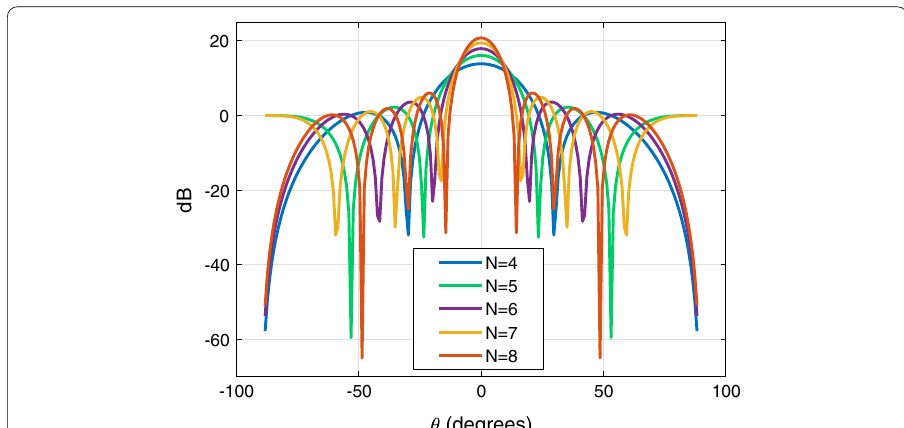
Fig. 4 Beam patterns corresponding to different receiving array elements